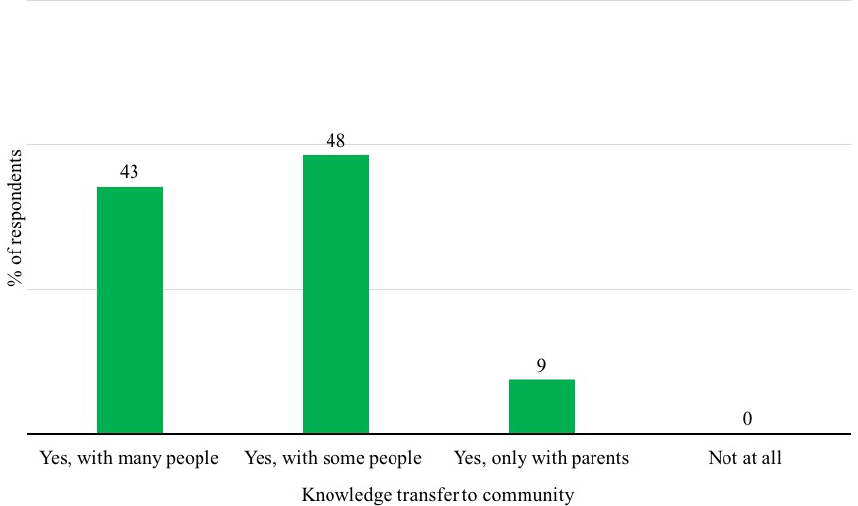
Figure 10. Student activities for transferring the knowledge to the community (question e), after the initiation of our education